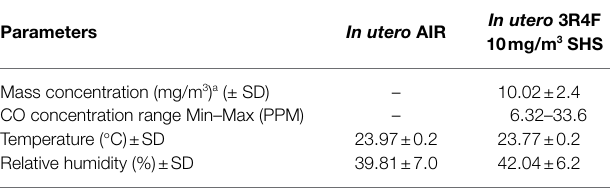
TABLE 3 | In utero SHS + urethane – Lung cancer study. Parameters In utero